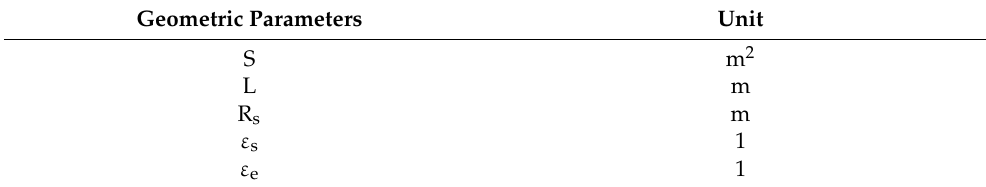
Table 2. Parameters classification of